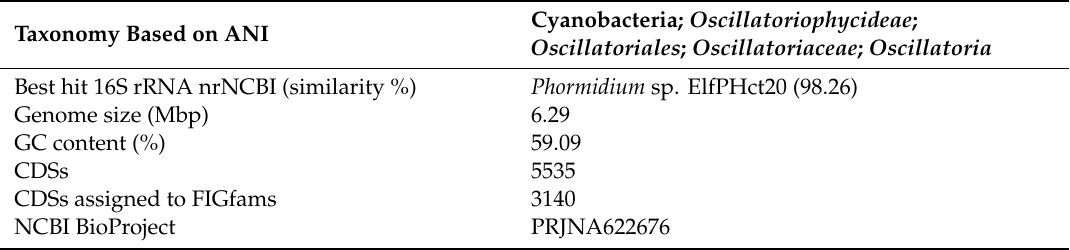
Table 1. Genomic characteristics of Phormidium sp. ETS-05.